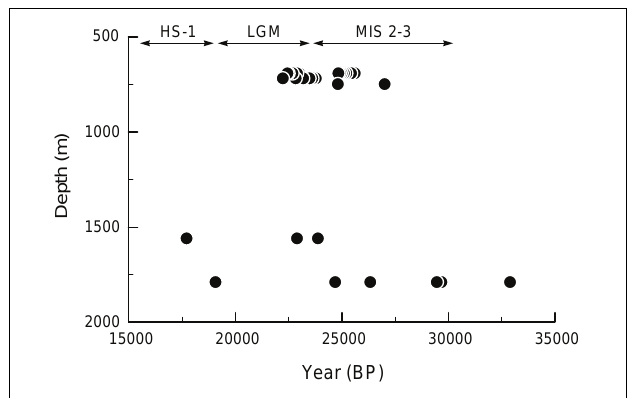
FIGURE 11 | U/Th ages relative to depth distribution of scleractinian corals from the Perth Canyon collected from two dive sites. These fossil coral ‘graveyard’ deposits occur at Sites C ( ∼ 1,500–1,800 m) and F ( ∼ 700 m). LGM, Last Glacial Maximum; MIS, Marine Isotope Stage; HS,